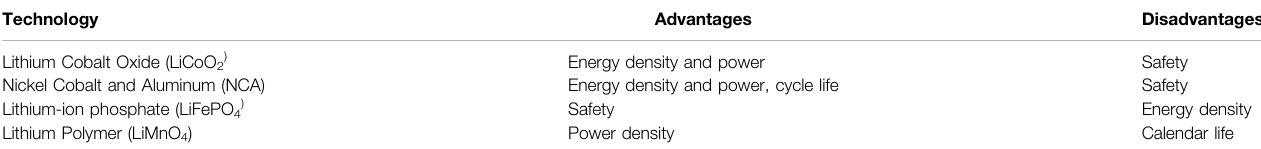
TABLE 5 | Comparison of various types of Li-ion batteries in term of advantages and disadvantages (Yatsui and Bai, 2011; Hannan et al., 2017). Technology